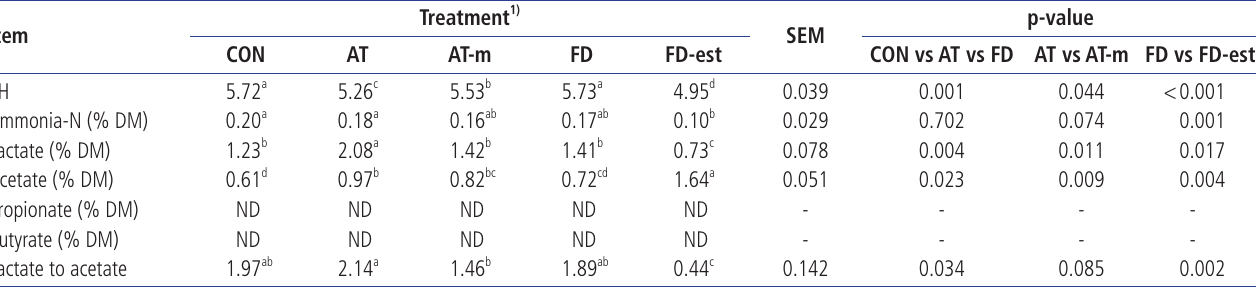
Table 3. Effects of wild and mutated inoculants on fermentation characteristics of rye silage ensiled for 90 d